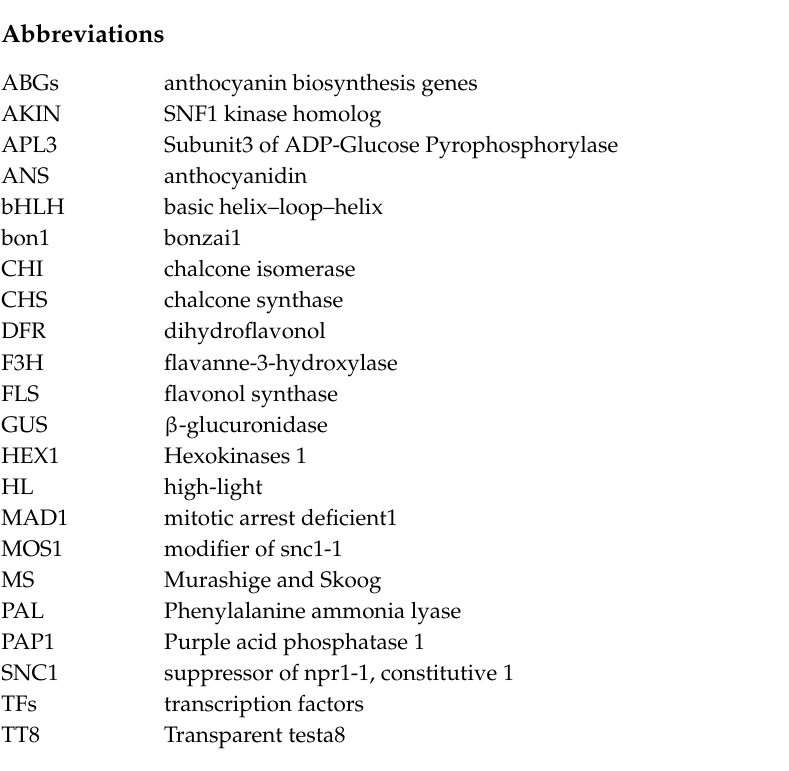
s1. Table S1: Primers sequences for RT-PCR in this study. Figure S1: Representative images of the germination of Col-0 and mos1 , #1 , and #2–9 grown on 1 / 2 MS medium with 0.8% sucrose, 6% Man, or 6% Suc. Figure S2: